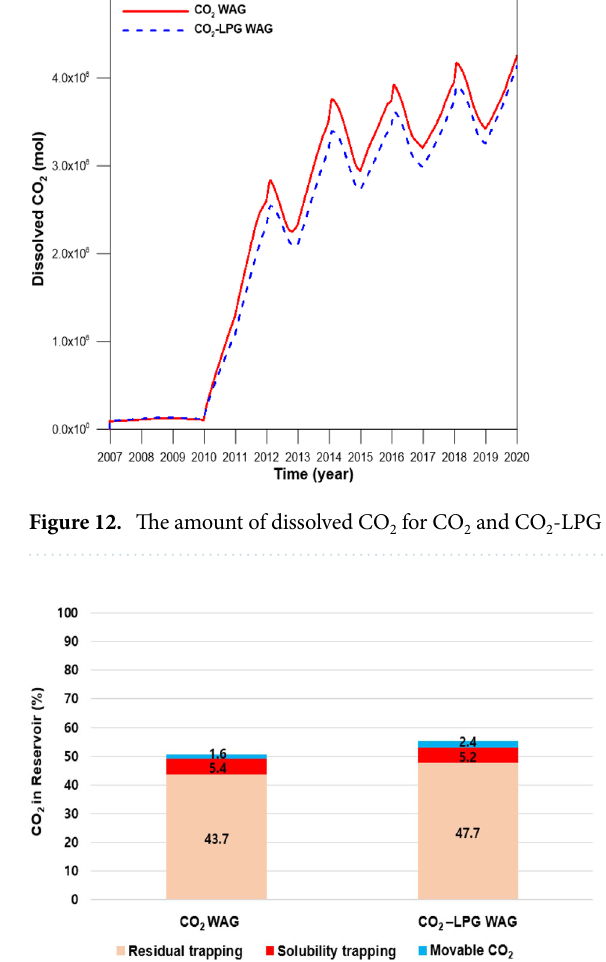
Figure 13. CO 2 remaining in the reservoir according to trapping mechanism.